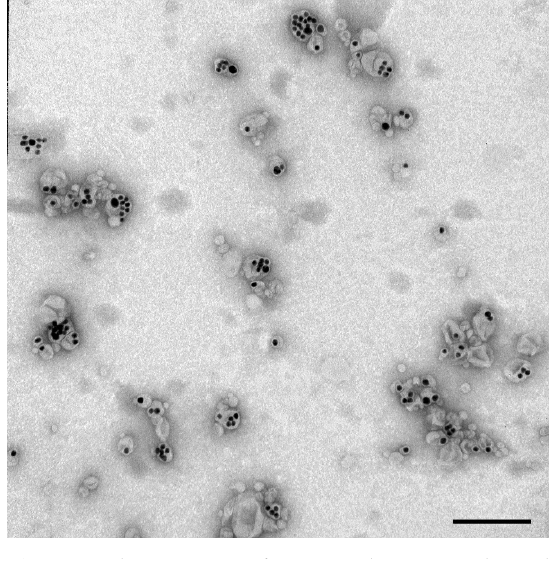
Figure 7. Ultrastructure of optimized MLNCs. The scale bar corresponds to 200 nm. Negative stain- ing with a 0.5% uranyl acetate solution followed by TEM.